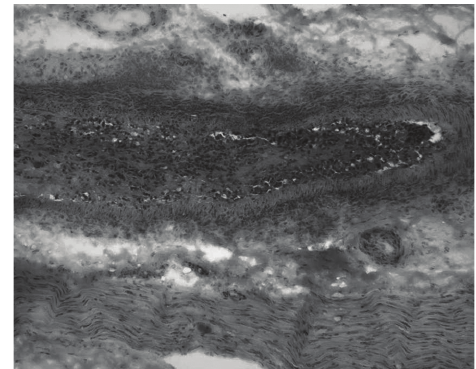
Figure 2: Biopsy of sural nerve in longitudinal section demon- strates features of necrotizing arteritis (NA) in a patient with dia- betic lumbosacral radiculoplexus neuropathy (DLRPN). Numerous inflammatory cells surround a small epineurial artery. The lumen contains reactive connective tissue with recanalization, thrombus formation, and vessel wall necrosis. An adjacent nerve fascicle has a marked loss of myelinated fibers (Cryosection, H&E,